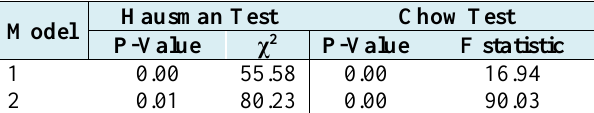
Table 1. Chow Test and Hausman Test